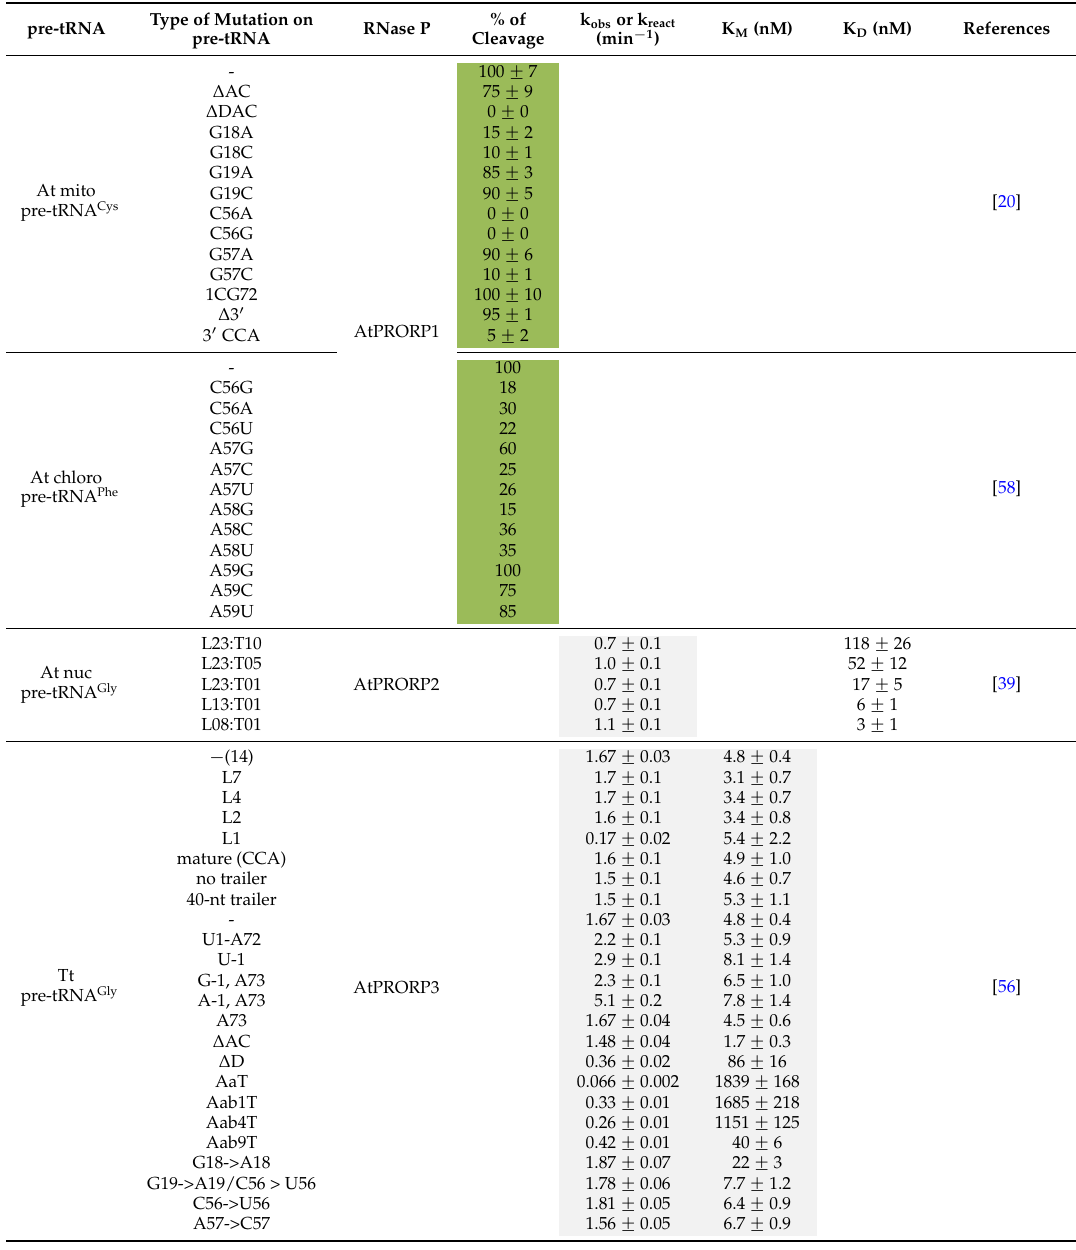
Table 2. Kinetic analyses of the importance of pre-tRNA cis -elements for RNase P cleavage by PRORP enzymes. At stands for Arabidopsis thaliana , Tt for Thermus thermophilus , Bs for Bacillus subtilis , “mito” for mitochondrial and “nuc” for nuclear. L and T indicate lengths of leader and trailer sequences respectively. “Aa” substrates represent minimal substrates lacking the tRNA anticodon and D domains as described by Brillante et al. [56]. Values for the results published by Imai et al. [58] are graphical estimates as numbers were not provided in the article. Grey boxes indicate results of single turnover kinetic experiments (with either k obs , the observed first order constant, or k react , the maximum rate constant, and its associated K M ), whereas green boxes indicate results of RNase P cleavage assays performed in multiple turnover